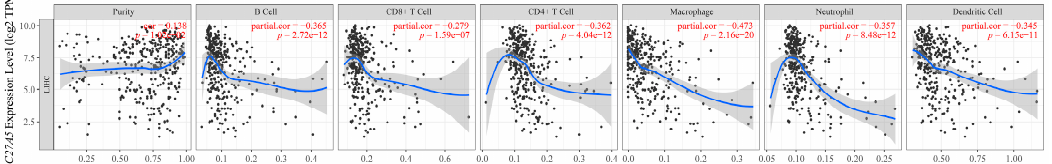
Figure 7. Correlation between SLC27A5 and infiltration levels of immune cells in HCC. Correlation analysis of SLC27A5 expression and infiltration levels of immune cells in HCC using the TIMER database. p < 0.05 and partial correlations < − 0.3 or > 0.3 were considered to be statistically significant correlations. Abbreviations: cor, correlation. TPM, transcripts per million; TIMER, Tumor Immune Estimation Resource.